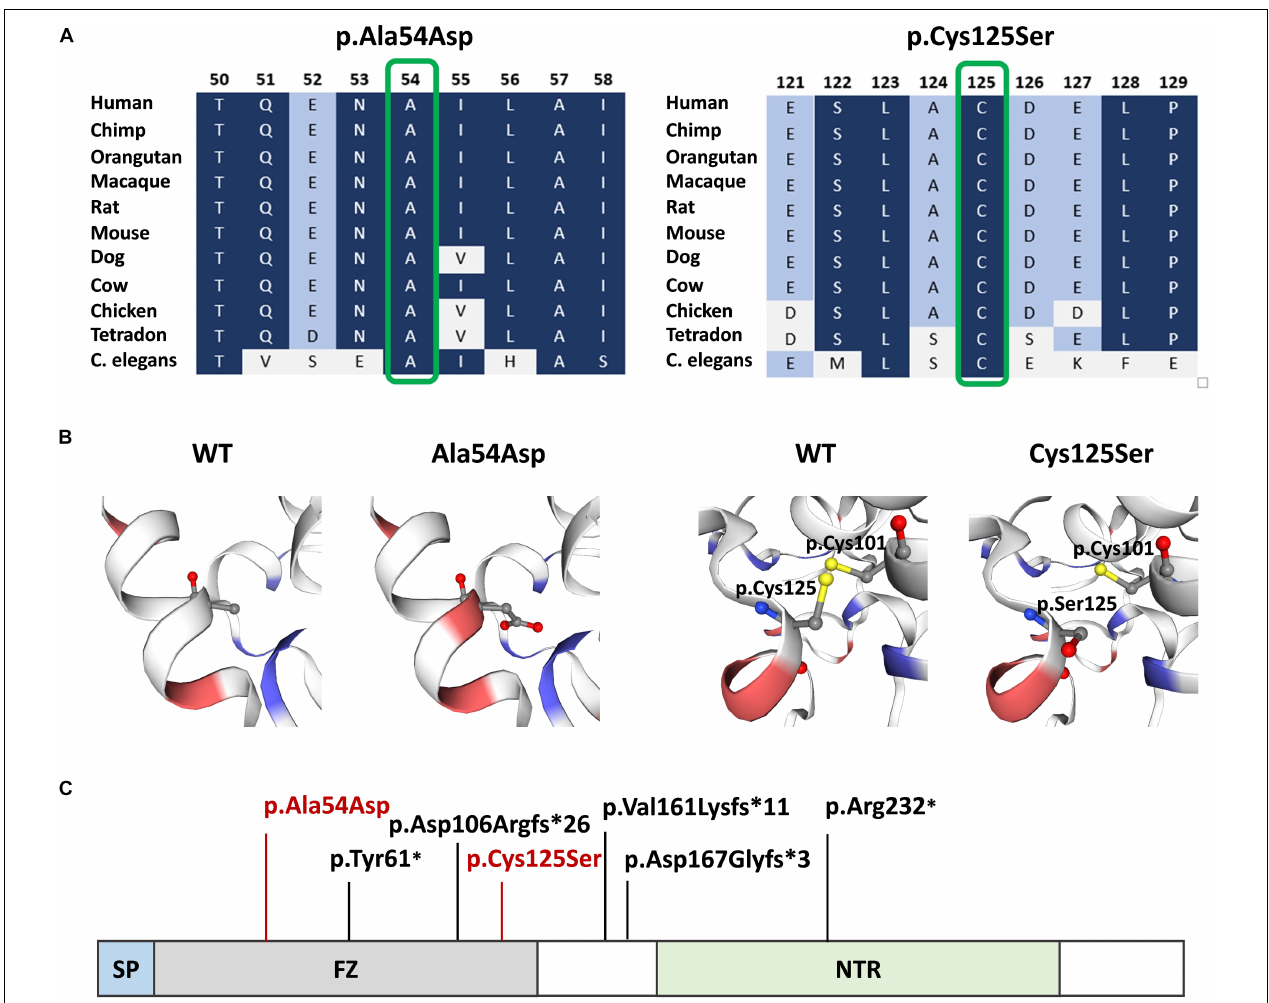
FIGURE 3 | SFRP4 protein structure and conservation. (A) Multiple sequence alignment of SFRP4 protein in 11 species available from Alamut R (cid:13) Visual software. Variants p.Ala54Asp and p.Cys125Ser are shown in green boxes. Residues with high conservation among species are shown in navy blue, whereas with lower conservation in blue and gray. (B) 3D prediction of p.Ala54Asp and p.Cys125Ser mutation sites and the corresponding WT loci. Red and blue colors indicate negatively and positively charged amino acids. Note the change of charge at position p.54 from non-polar—alanine to negatively charged—aspartic acid. Sulfhydryl side chains of cysteines at positions p.125 and p.101 are indicated in yellow. Disulfide bond is represented by a yellow bar. Note the absence of the disulfide bond in the mutated (p.Cys125Ser) protein. (C) Schematic representation of SFRP4 protein. Previously reported mutations are marked in black. The mutations identified in this study are marked in red. SP, signal peptide; FZ, frizzled domain; NTR, netrin-like